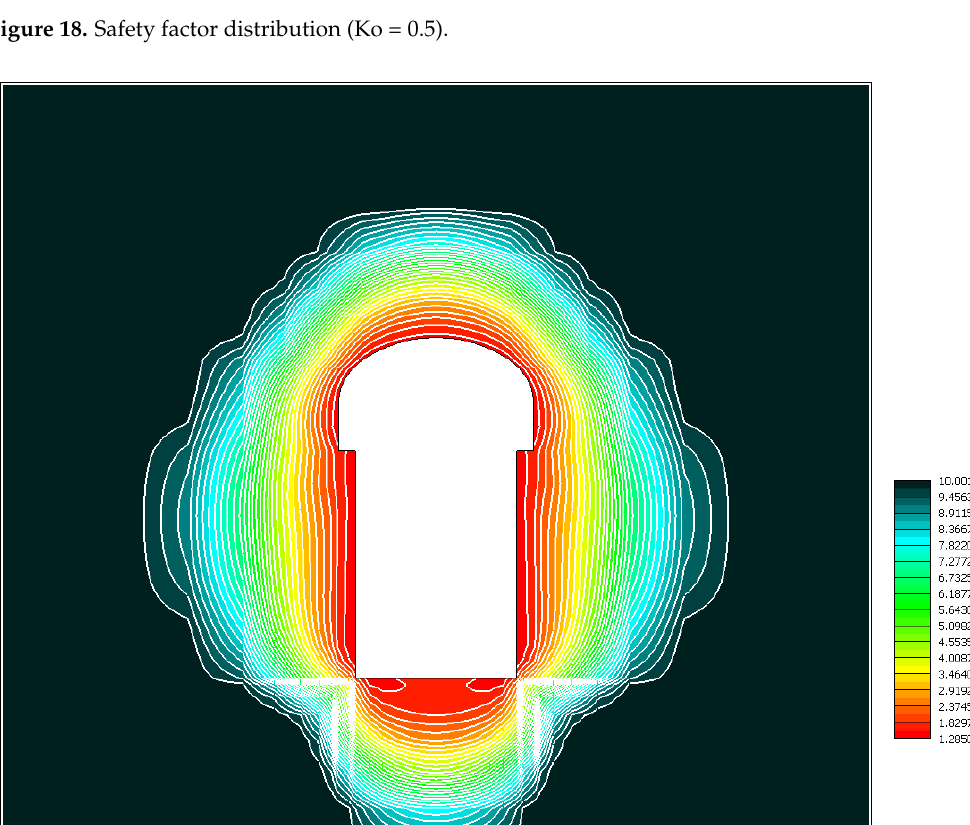
Figure 19. Safety factor distribution (Ko = 1.0).